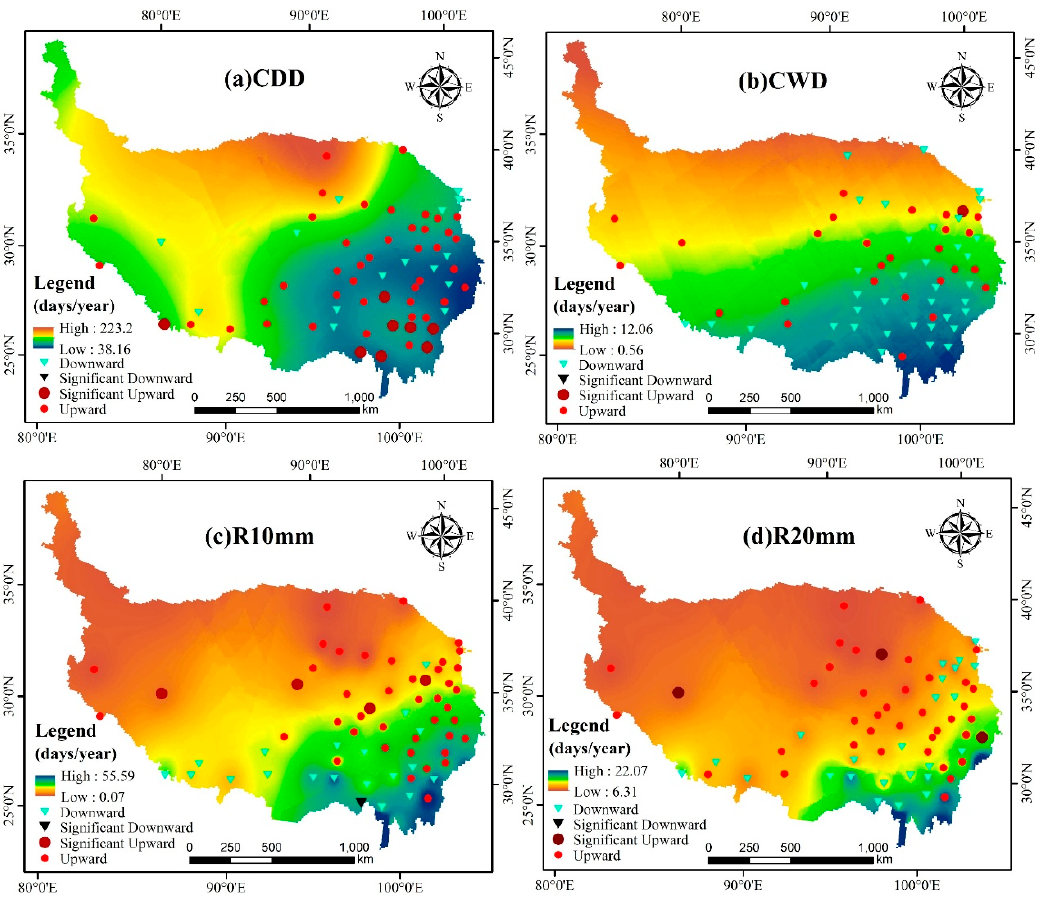
Figure 4. Spatial pattern of values and trends in indices for the number of precipitation days in the Tibetan Plateau from 1986 to 2015 for ( a ) CDD, ( b ) CWD, ( c ) R10mm, and ( d ) R20mm. The blue triangles represent a downward trend, the black triangles represent a significant downward trend, the red circles represent an upward trend, and the dark red circles represent significant upward trend. A significance level of 0.05 is considered.